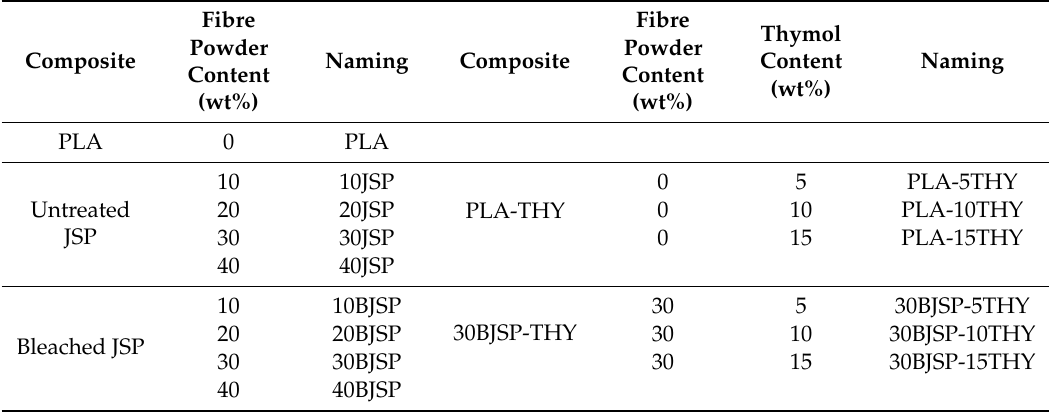
Figure 1. Flow diagram of the current study’s methodology. Table 1. Formulation of poly(lactic acid) (PLA) and PLA